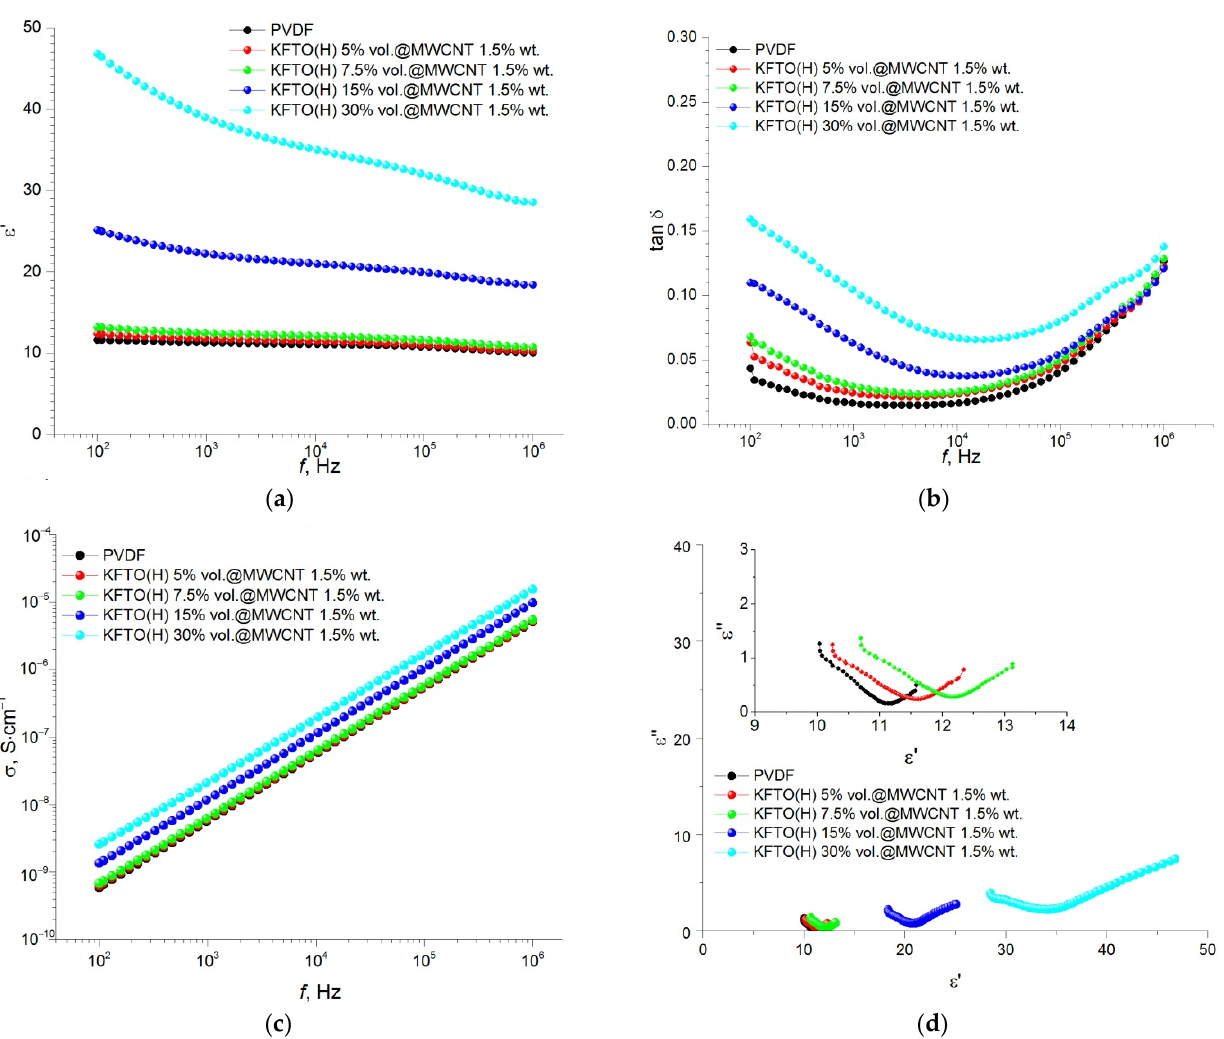
Figure 10. Frequency dependence of ( a ) permittivity, ( b ) dielectric loss tangent, ( c ) conductivity and ( d ) Cole–Cole plot ( ε ′ – ε ″ ) for PVDF-based composites with different volume fractions of KFTO(H) with MWCNT additive of 1.5 wt.% (inset is the enlarged view of the basic figure).